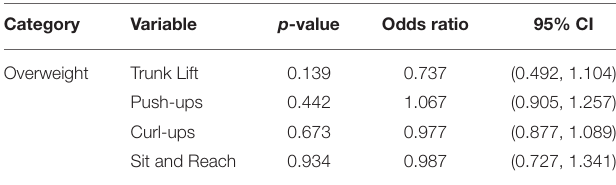
TABLE 6B | Associations between musculoskeletal fitness and weight status in fourth grade (reference group: obese).